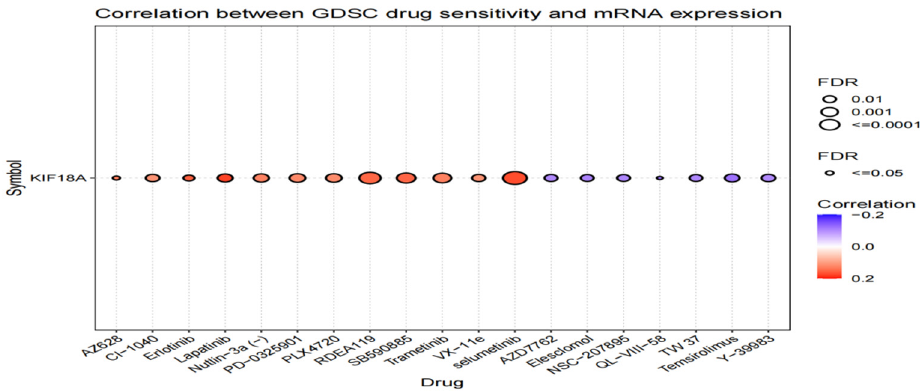
Figure 10. The associations of KIF18A expression and drug sensitivity base on GSCALite.